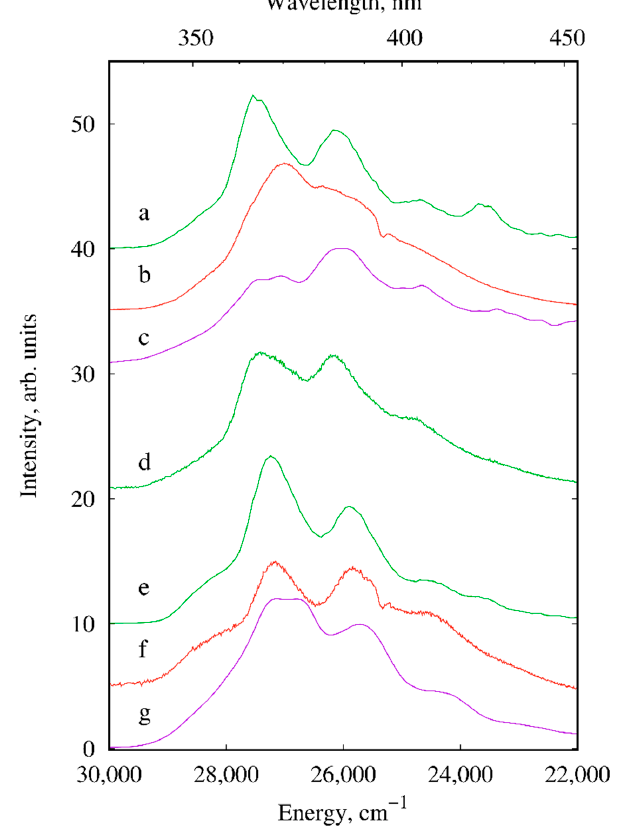
Figure 7. The d-block luminescence of III ( a ), I ( b ), II ( c ), V ( d ), VIII ( e ), VI ( f ) and VII ( g ) (solid samples, λ ex = 280 nm, T = 300 K). The narrow emission bands of complexes I and VI correspond to the 5 D 0 → 7 F J ( J = 0–4) transitions of Eu 3+ (Figure 5). The integrated intensity ratios of 5 D 0 → 7 F 2 hypersensitive transition to the magnetic dipole transition 5 D 0 → 7 F 1 of europium compounds I and VI are 4.06 and 5.97, respectively, and indicate a deviation of the Eu 3+ site symmetry from the inversion center. The 5 D 0 → 7 F 0 transition displays a single symmetrical narrow component in all cases that indicates the presence of only one type of the Eu 3+ environment. This is confirmed by the fact that all luminescence decay curves of the excited 5 D 0 level of Eu 3+ and of the excited 5 D 4 level of Tb 3+ were well fit by a monoexponential decay function (Table 3). Table 3. Radiative (A rad ) and non-radiative (A nrad ) rate constants, luminescence lifetimes ( τ ), intrinsic ( 𝑄 (cid:3013)(cid:3041) (cid:3013)(cid:3041) ) and overall ( 𝑄 (cid:3013)(cid:3041) (cid:3013) ) quantum yields and sensitization efficiency ( 𝜂 sens ) of I, III, IV, VI and VIII. Compound